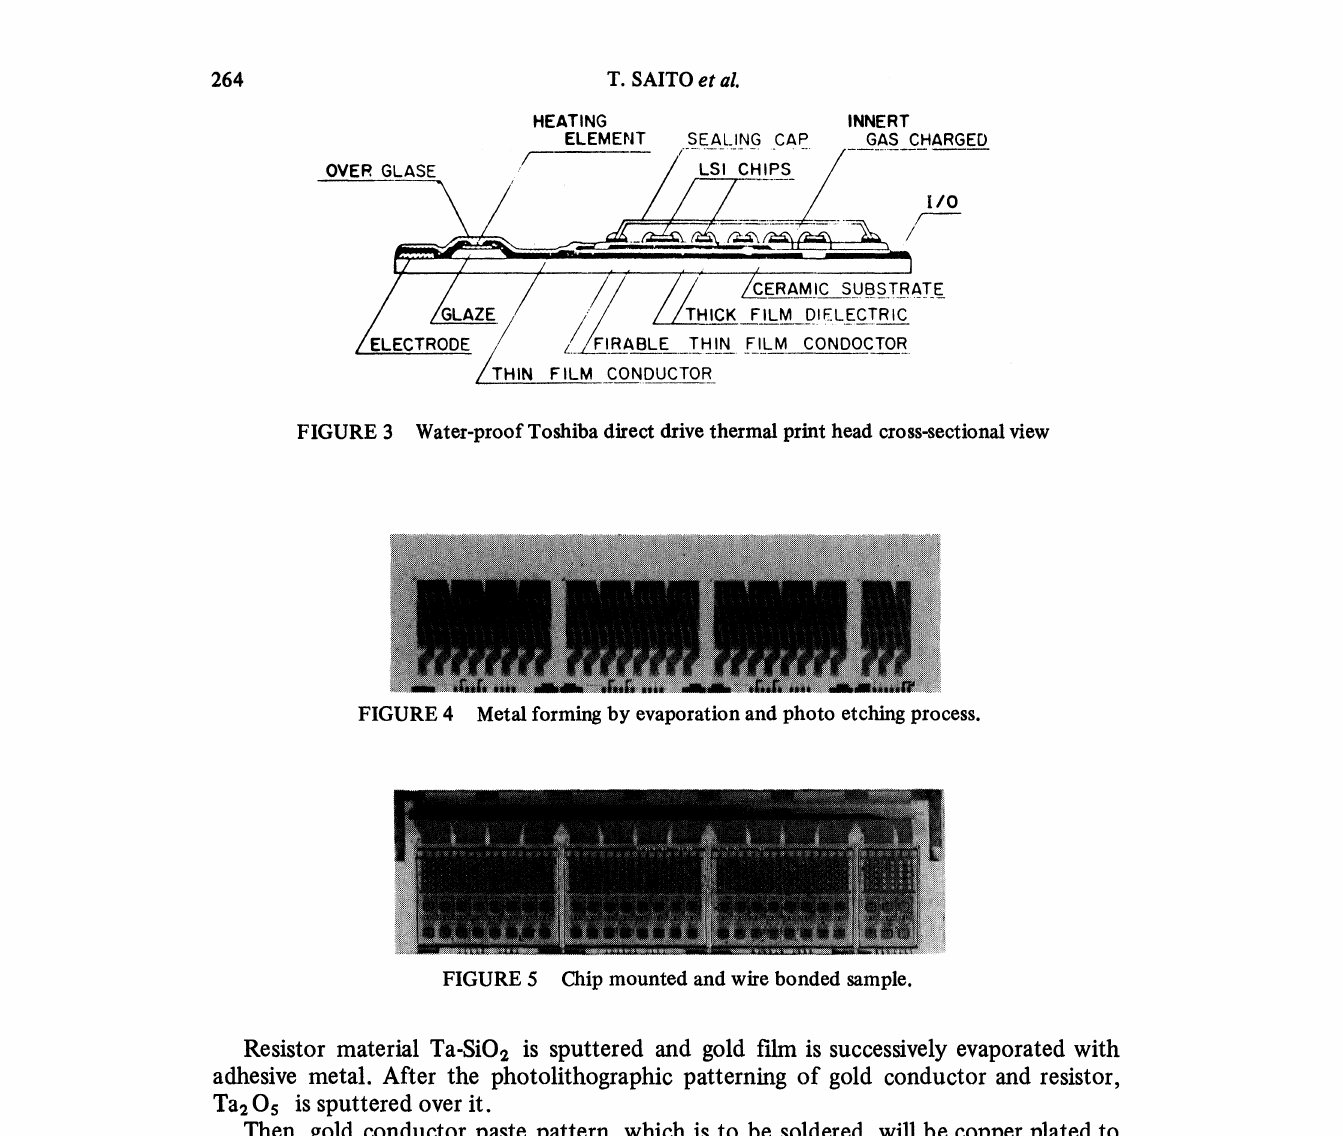
FIGURE 5 Chip mounted and wire bonded